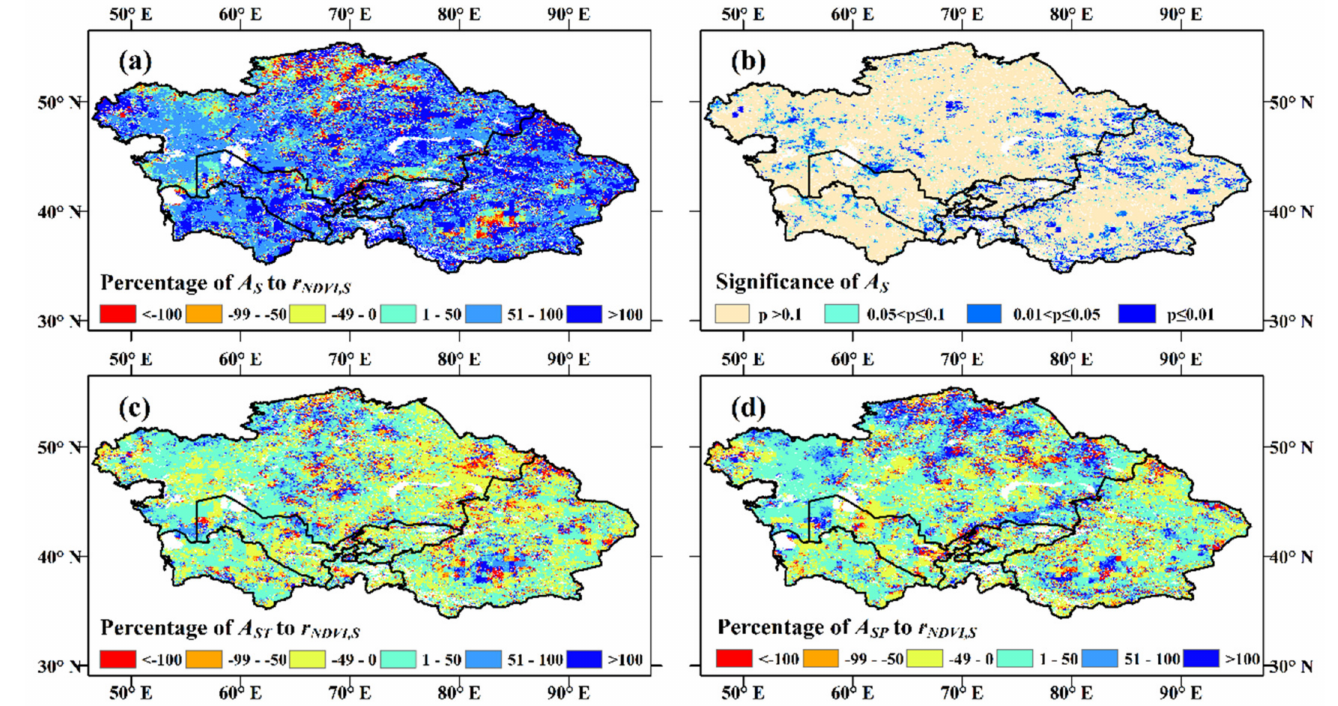
Figure 9. Extent ( a ) and significance ( b ) of the direct effect of winter snowfall ( A S ) on growing season vegetation greenness, the extent ( c ) of the indirect effect of winter snowfall via the growing season temperature ( A ST ), and extent ( d ) of the indirect effect of winter snowfall via growing season precipitation ( A SP ). r NDVI,S represents the correlated coefficient between winter snowfall and growing season